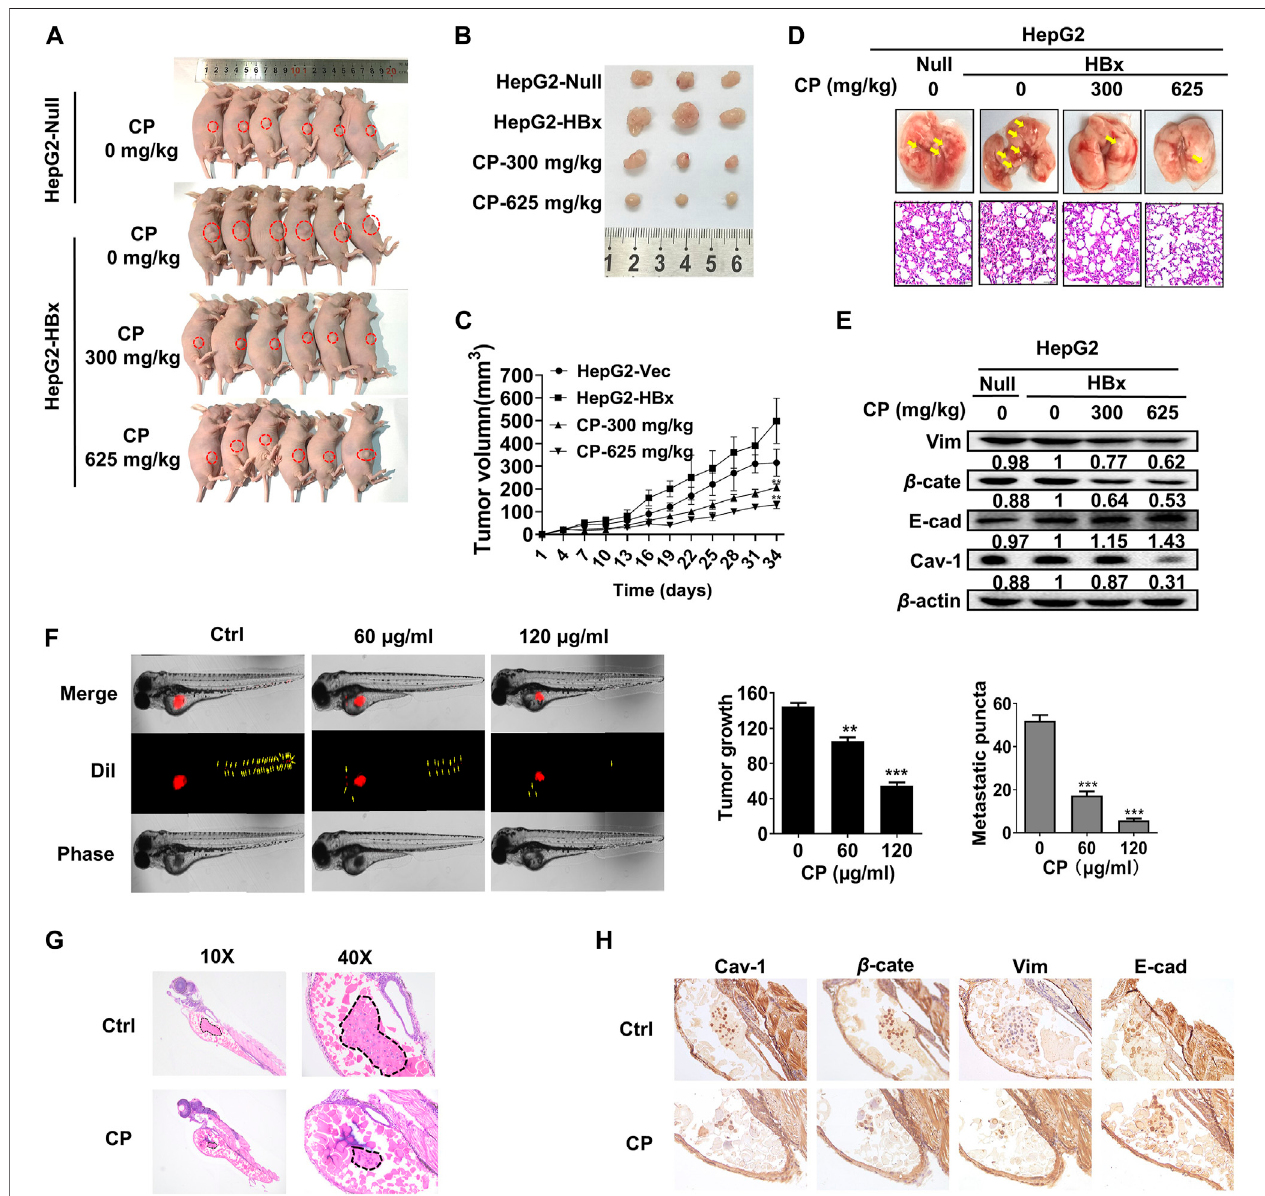
FIGURE8| CPinhibitedproliferationandmigrationofHBV-associatedHCC exvivo and invivo . (A – C) HepG2-nullandHepG2-HBxcellsweregraftedtothe fl ankof nude mice by injecting the cells subcutaneously to observe tumor development, and volumes of tumors were determined at 3-day intervals. (D) Mice model with lung metastasis was established by tail vein injection of cancer cells. Upper panel, metastatic nodules in lungs. Lower panel, H&E staining of lung tissues. (E) Western blot analysis of tumor tissue showed that CP treatment decreased the expression levels of β -catenin and Cav-1, and enhanced the EMT process. (F) CP at concentrations from60to120 μ g/ml signi fi cantly decreased theprimary aswell asmetastaticlesions inthezebra fi shbody when compared withcontrol group. (G) H&E staining showed that CP suppressed the tumor growth in zebra fi sh. (H) Immunohistochemical staining of tumor in zebra fi sh showed CP treatment dramatically downregulatedtheexpressionlevelsof β -catenin,Cav-1andVimentin,andupregulatedtheexpressionlevelofE-cadherin.Allvaluesrepresentedthemeans ± SD( n (cid:1) 6, * p < 0.05, ** p < 0.01, *** p <